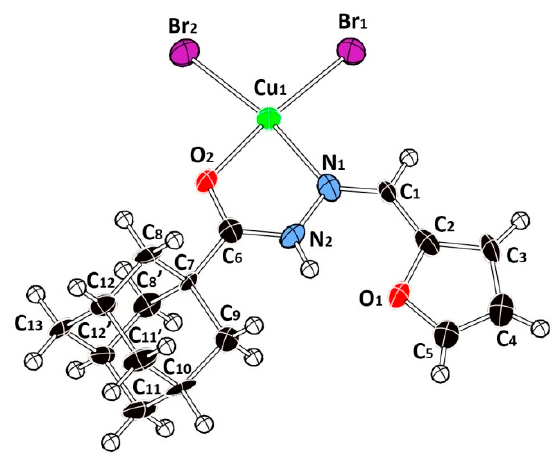
Figure 1. Thermal ellipsoid drawing (50% probability level) of the asymmetric unit of 1 . Table 1. Crystal data and structure refinement parameters for 1 .